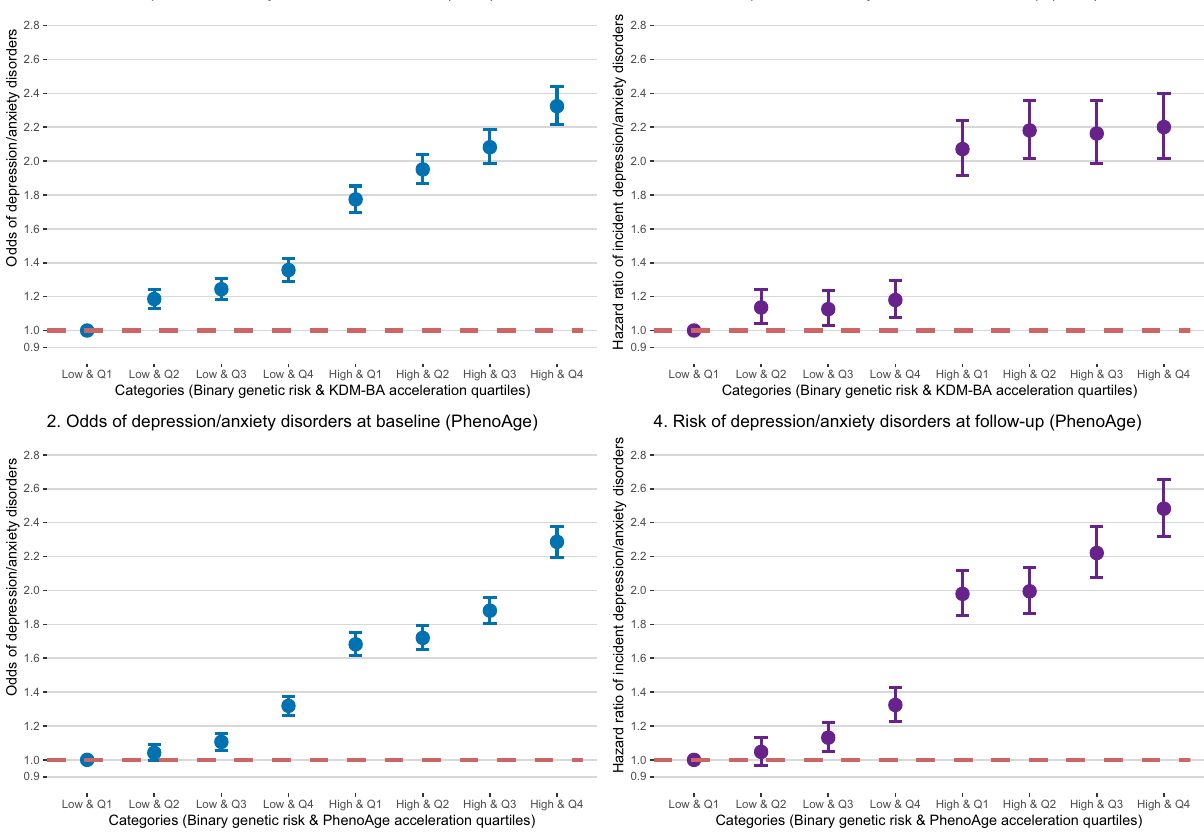
Model adjusted for age, sex, BMI category, race, smoking status (current/former/ never), healthy alcohol intake status, healthy physical activity status, Townsend deprivation index, and prevalent hypertension, CHD, and diabetes. The examina- tioncenterwasadditionallycontrolledforasarandomeffect.Two-sidedstatistical tests were conducted and no adjustments were made for multiple comparisons. Source data are provided as a Source Data fi